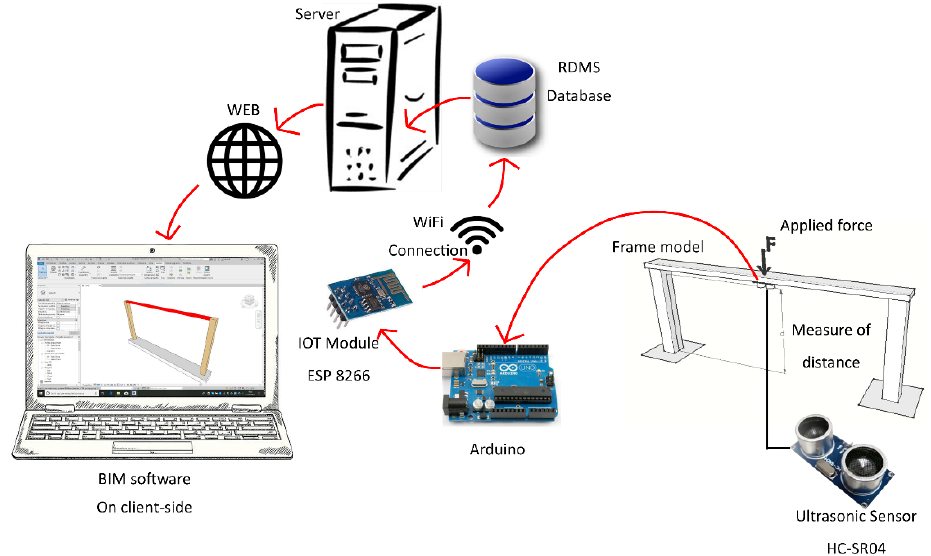
Figure 1. Application scheme.